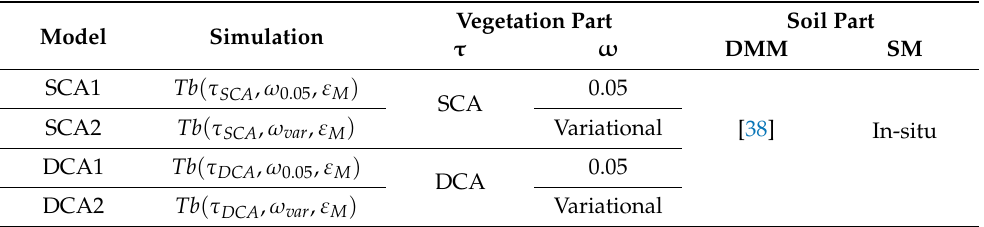
Table 1. Experimental set up to validate the e ff ect of time-varying vegetation scattering albedo ω in the τ - ω model.